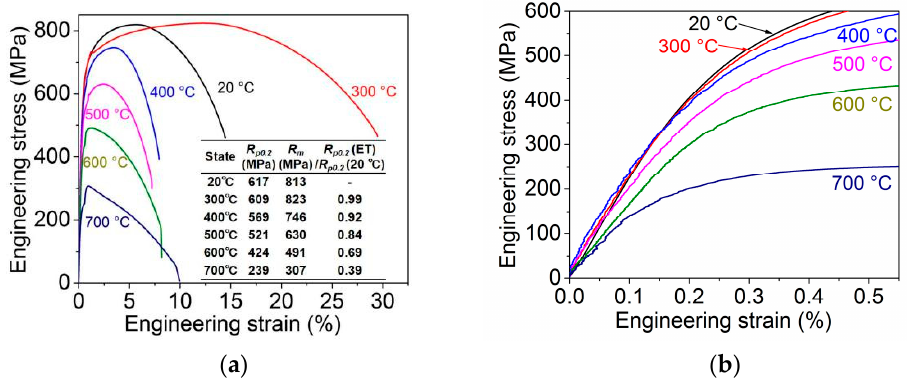
Figure 2. The engineering stress-strain curves of experimental steel at different temperatures: ( a ) the whole engineering stress-strain curves; ( b ) the enlarged engineering stress-strain curves.